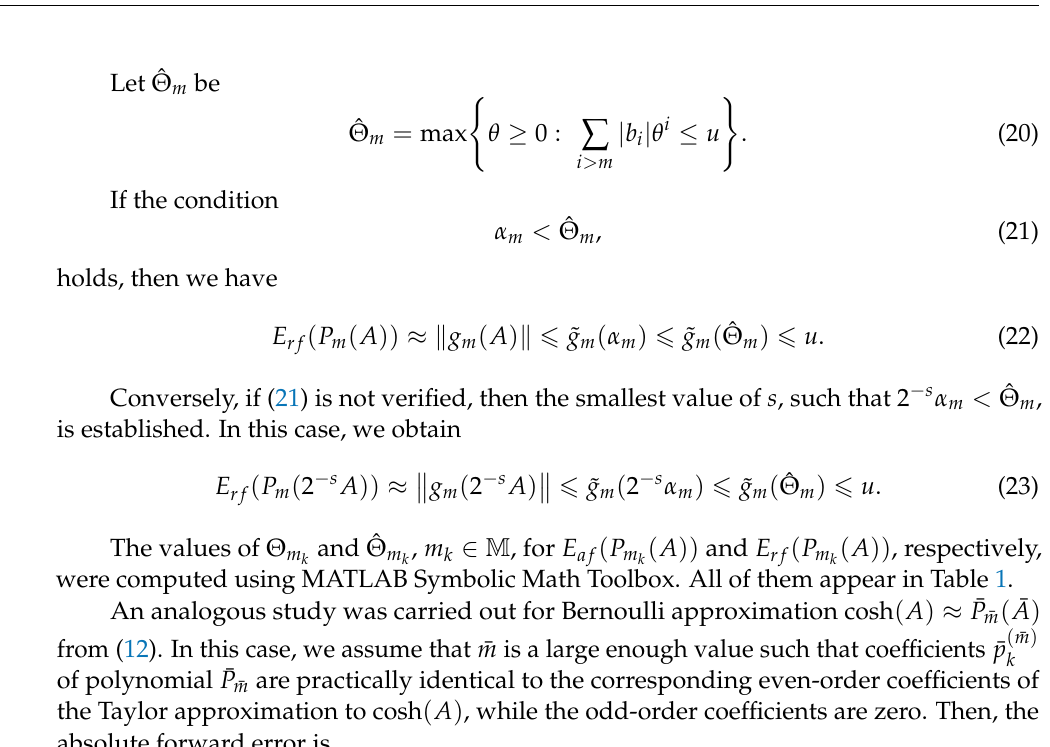
( P m ( A )) , respectively. rf k